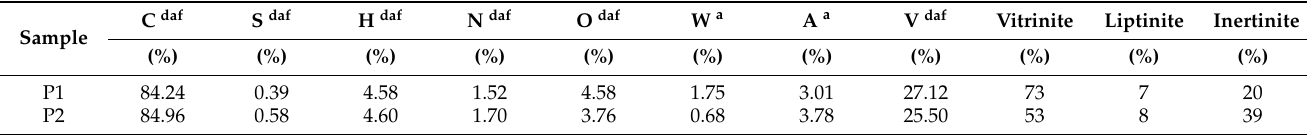
Table 1. Specification of the tested coal samples.